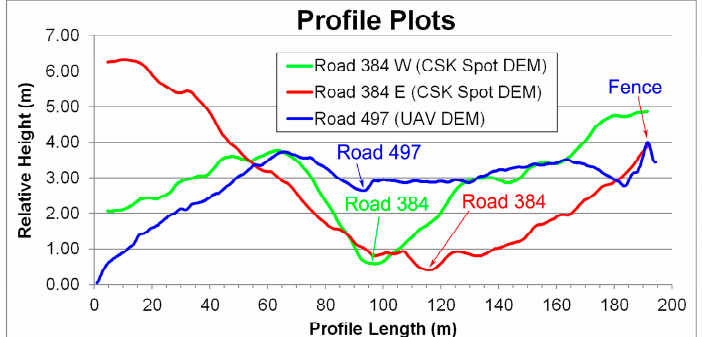
Figure 43. Graph showing height profiles over archaeological residues: western (green) and eastern (red) parts of Road 384, both taken from SBAS DEM derived from CSK Spotlight data, and Road 497 (blue), taken from DEM derived from UAV photogrammetry. Annotations for each profile are shown in their respective colours. The locations of the profiles are shown in Figure 38.